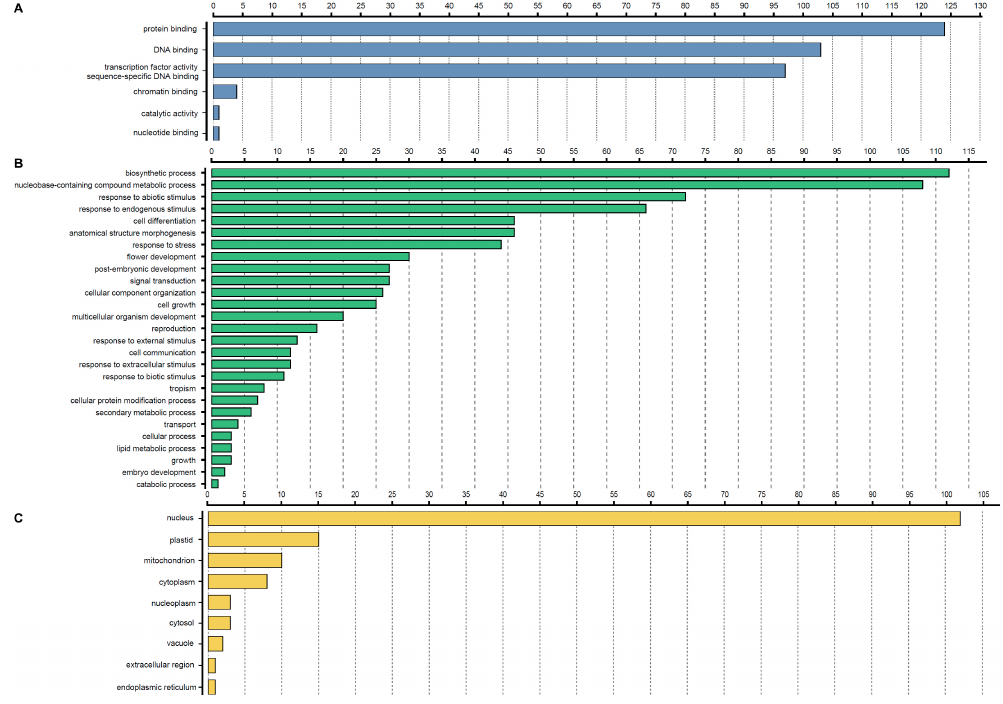
Figure 4. Gene ontology (GO) annotation of StbHLH proteins. The annotation was performed on three categories, ( A ) molecular function, ( B ) biological process and ( C ) cellular component.